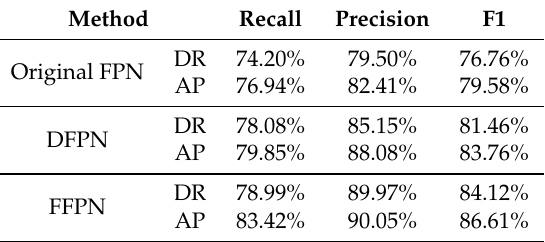
Table 2. Performance of models with Original Feature Pyramid Networks (FPN) [21], Dense